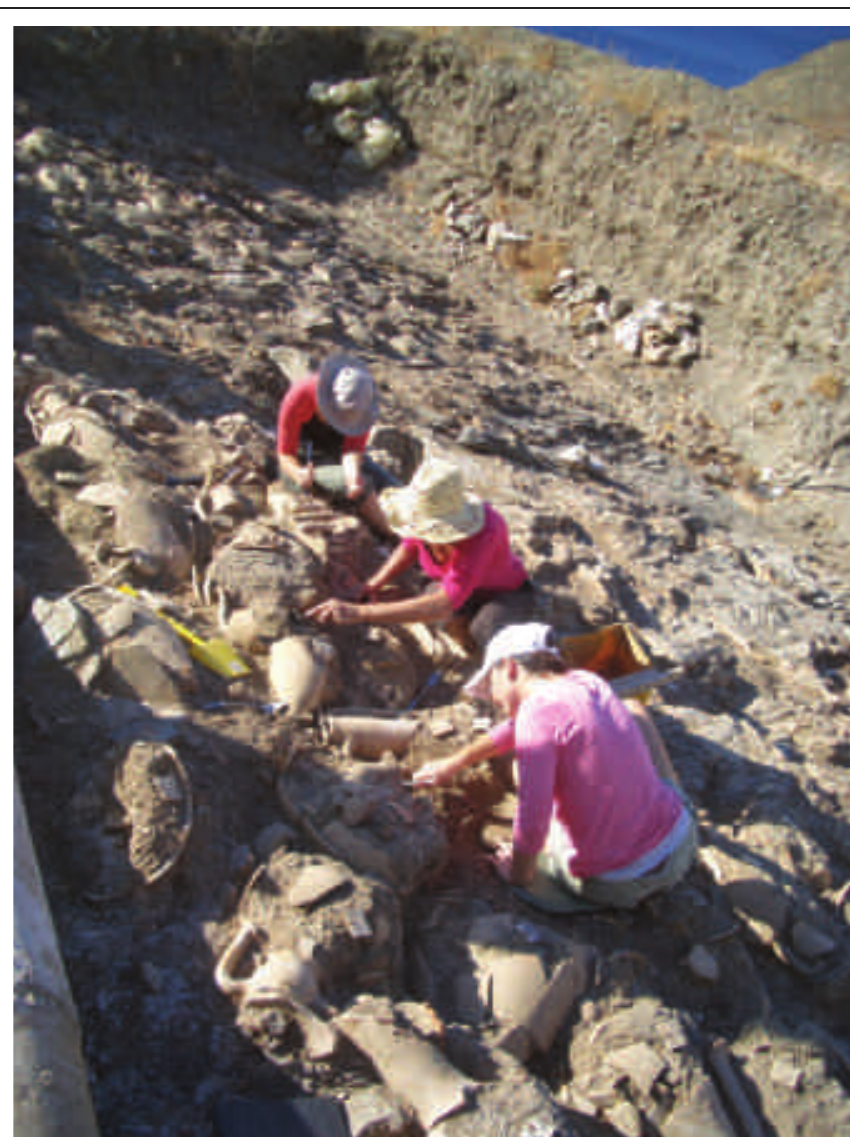
Figure 5 Excavations at the Kylindra infant